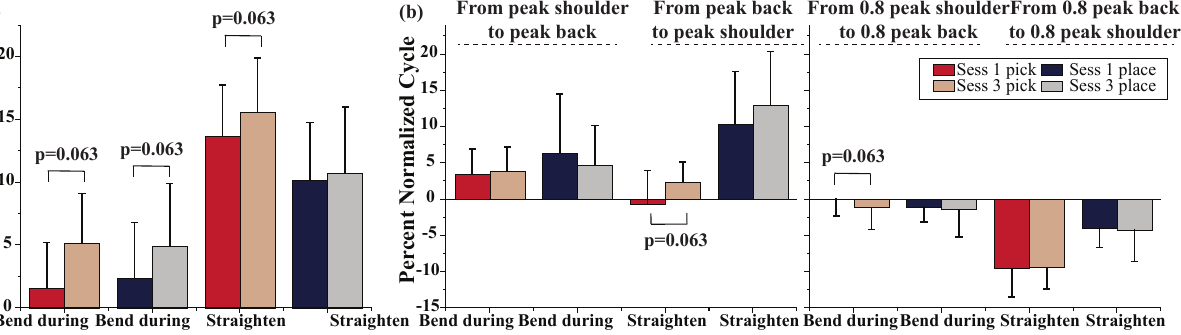
Figure 7. Back and shoulder coordination; ( a ) enclosed area between the mean back and shoulder flexion profiles during the four events are compared between the first and last sessions. ( b ) Percent time difference (after time normalization of profiles) between the maximum and 80% of maximum back and shoulder flexion are compared between the first and last sessions during the four